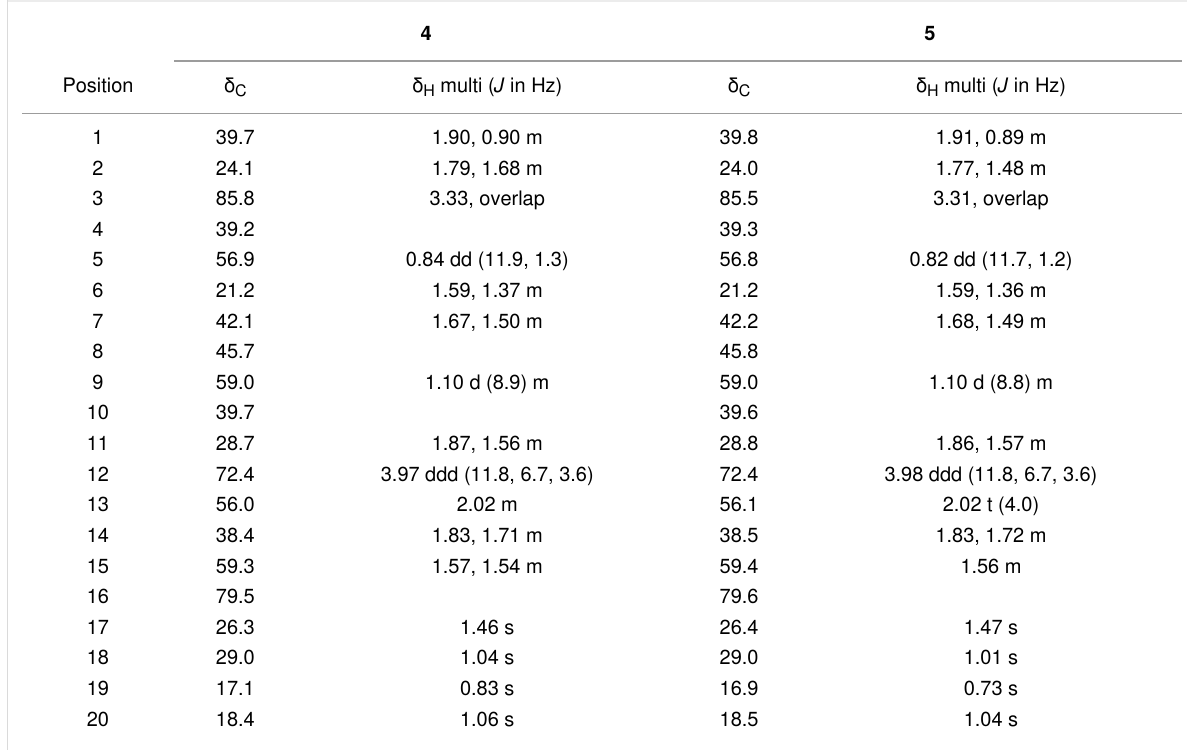
Table 3: 1 H (700 MHz) and 13 C (175 MHz) NMR data of compounds 4 and 5 in methanol- d 4 .